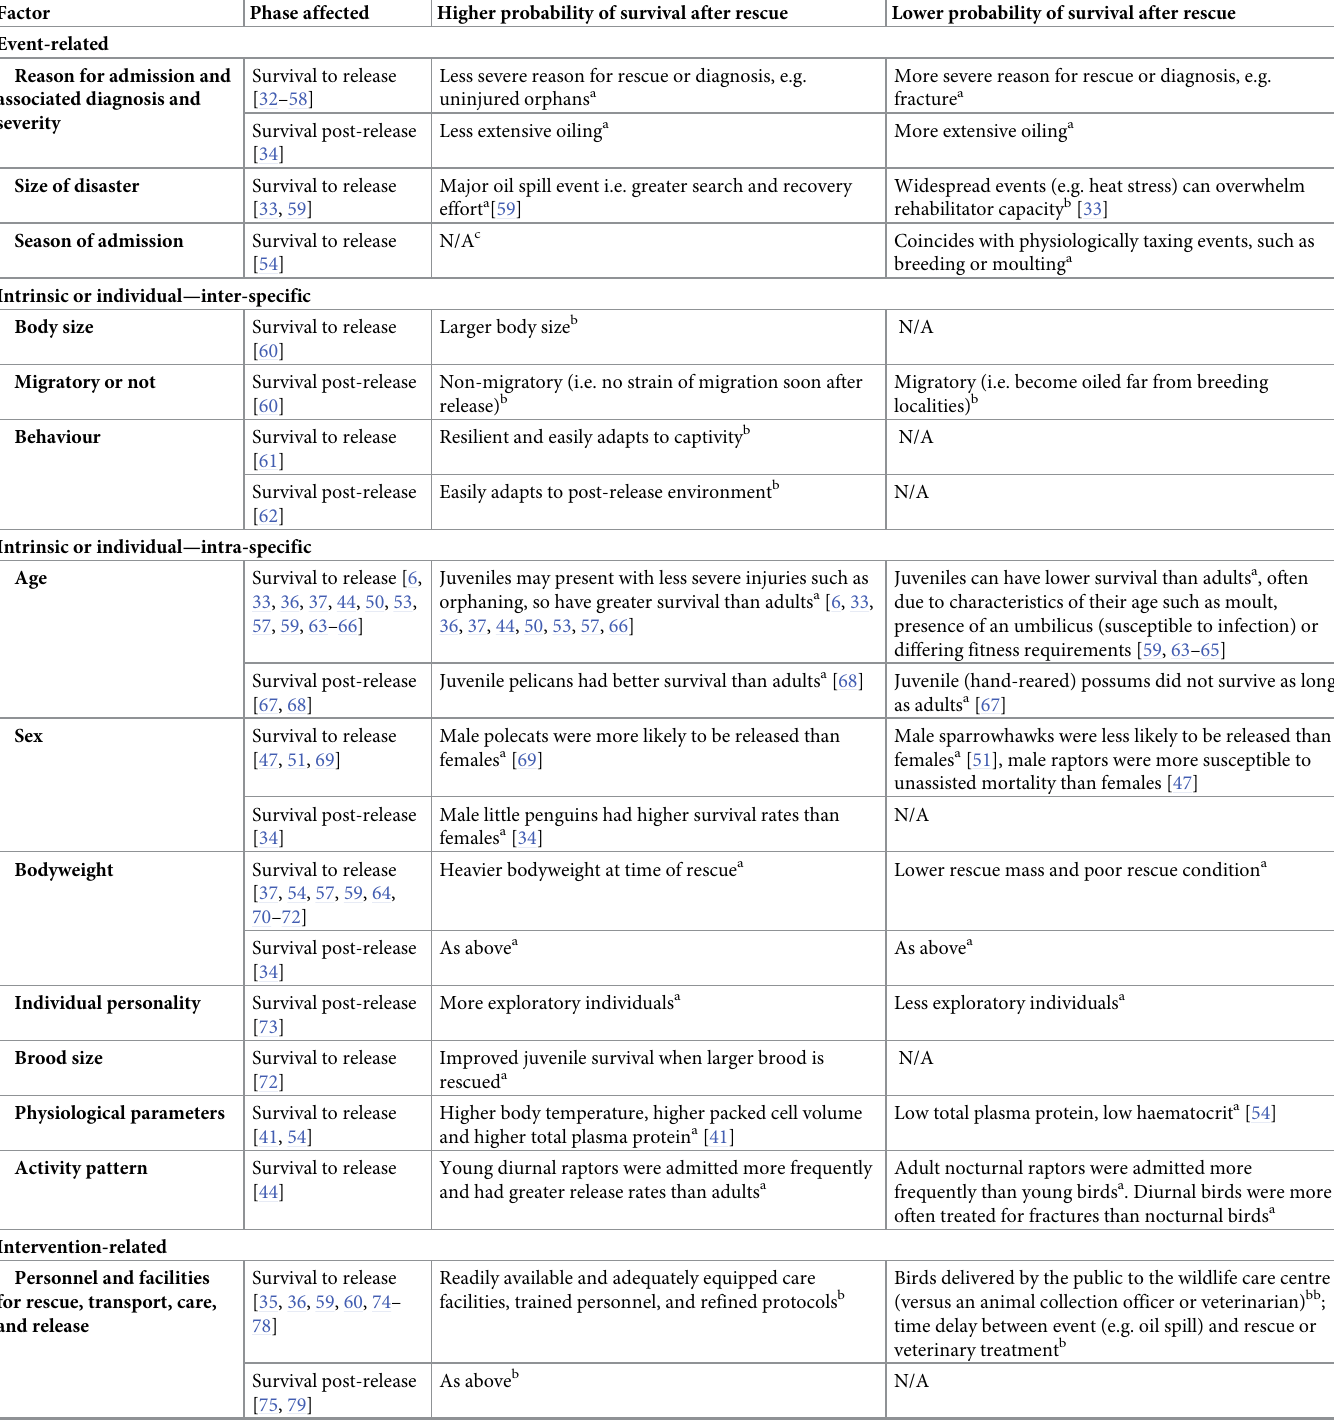
Table 4. A summary of factors associated with wildlife survival during rehabilitation and after release, with the direction of effects (higher or lower probability of survival), and factors categorised into event-related, intrinsic or individual (inter-specific and intra-specific), intervention-related, release environment, and human-wildlife interface (see S5 Table for full list of species